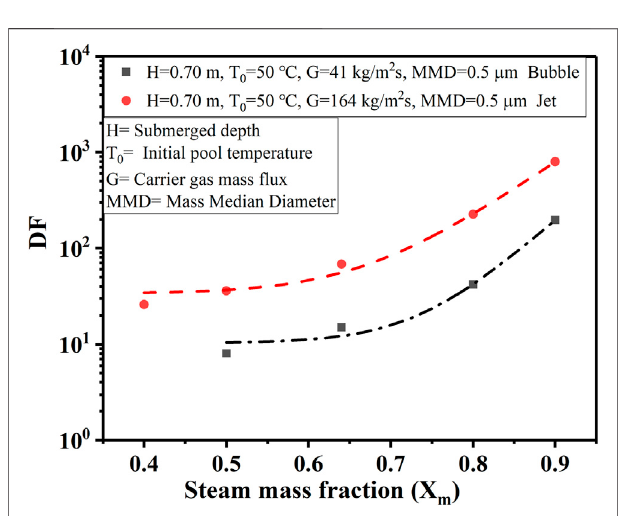
FIGURE 7 | Steam mass fraction effect on decontamination factor (DF).